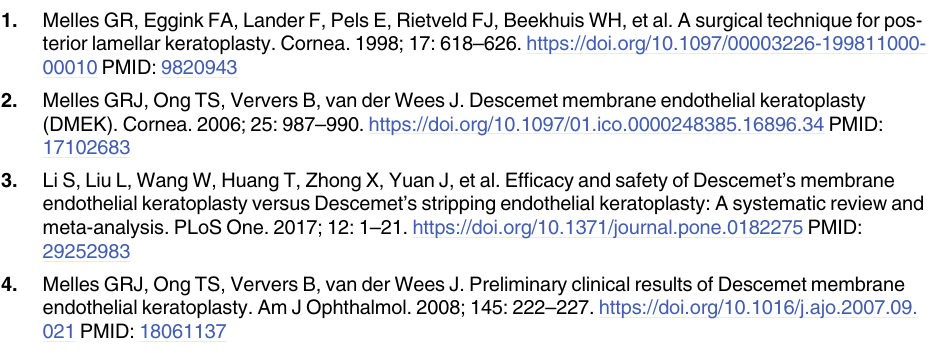
S1 Table. Evolution of CCT and BSCVA after surgery. S2 Table. Correlations between preoperative and postoperative CCT. S3 Table. Comparison of eyes with low preoperative CCT ( < 625 μ m) and high preopera- tive CCT ( � 625 μ m) in terms of postoperative